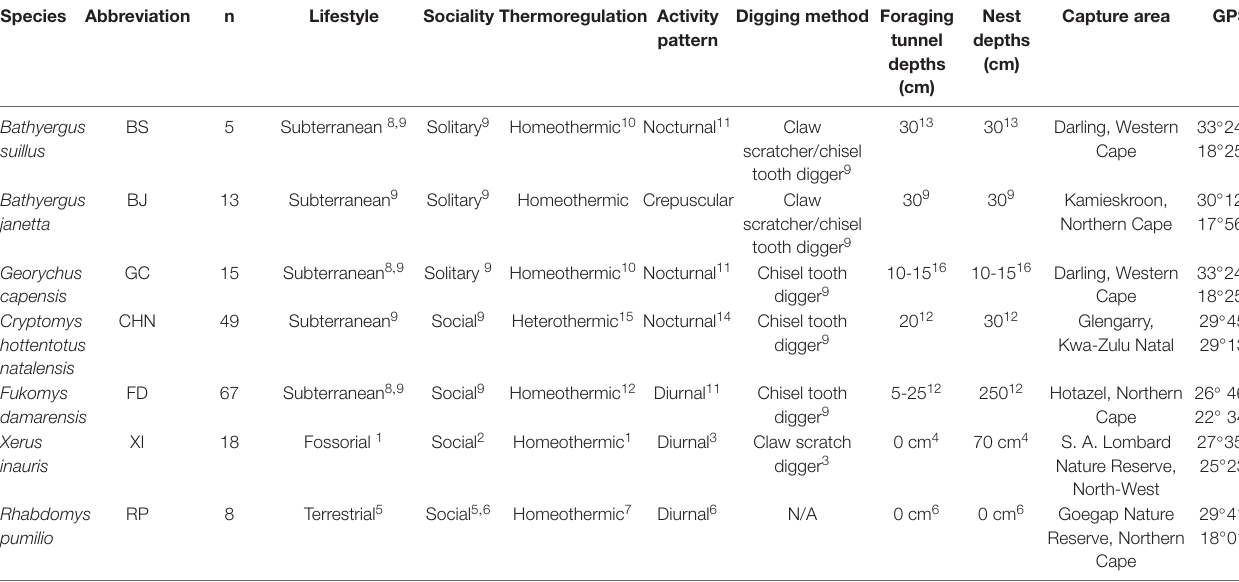
TABLE 2 | Scientific names and life history characteristics of the five mole-rat species and two aboveground foraging rodent species used in this study. Species Abbreviation